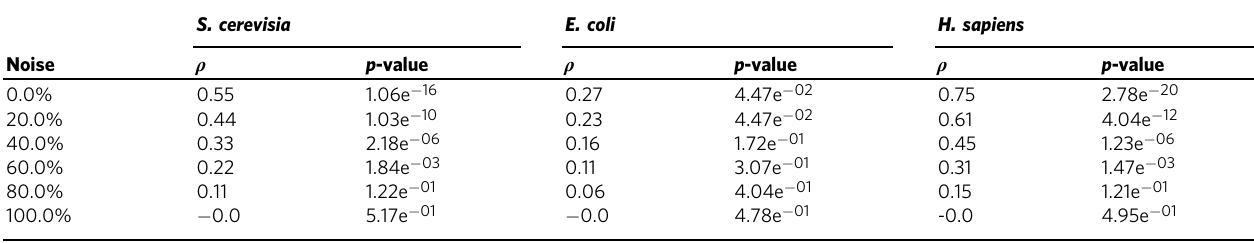
Table 2 Spearman rank correlation, ρ , between the degree and gene expression of a network at different levels of